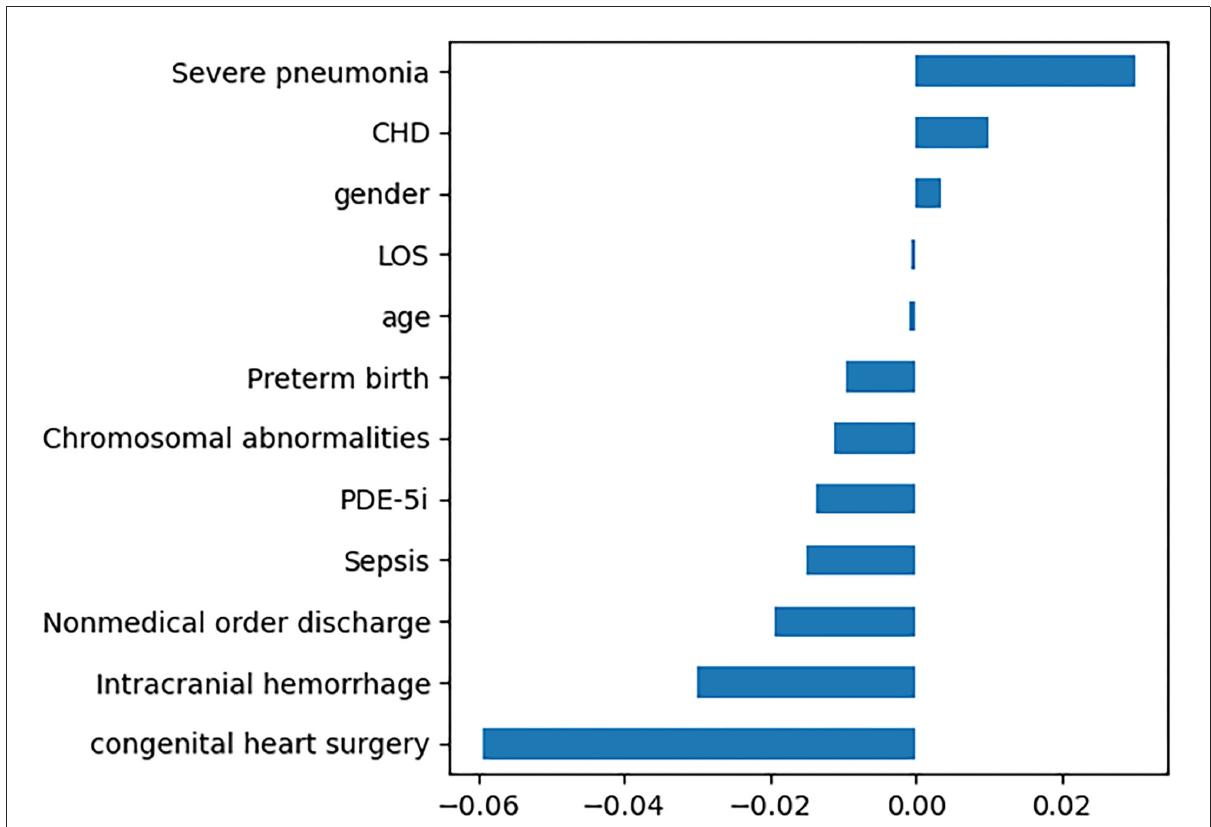
FIGURE2 Twelve features with non-zero regression coefficients. LOS, length of stay; PDE-5i, phosphodiesterase 5 inhibitors; CHD, congenital heart disease.